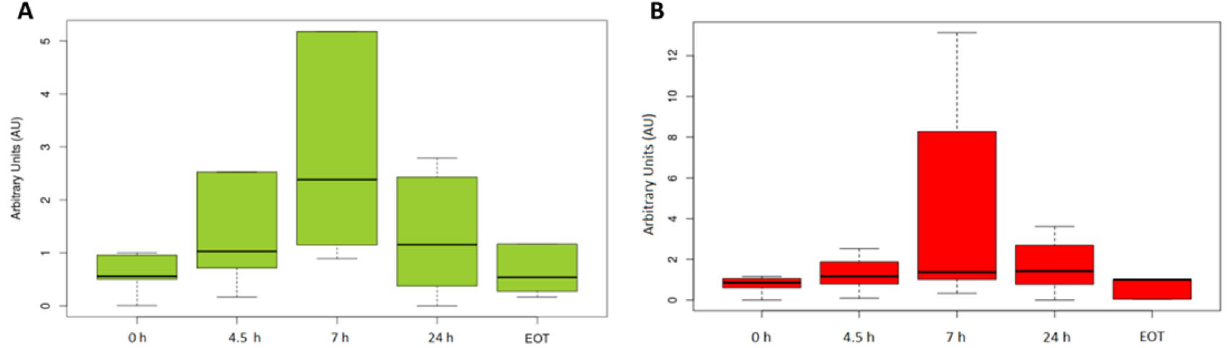
Figure 3. ( A ) Boxplot comparing RAD51 protein level in peripheral blood mononuclear cell (PBMC) samples at different times during treatment. ( B ) Boxplot comparing γH2AX protein’s level in PBMC samples at different times during